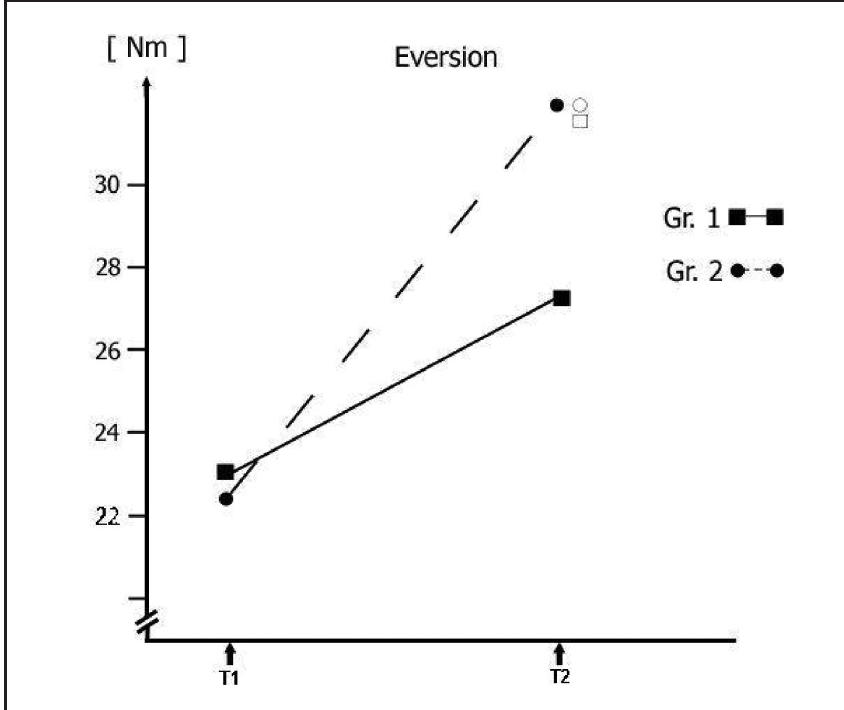
Figure 3: Maximum isokinetic torque in the eversion of the injured ankle in the comparison groups at the beginning of the investigation (T at the end of the investigation (T the uninjured